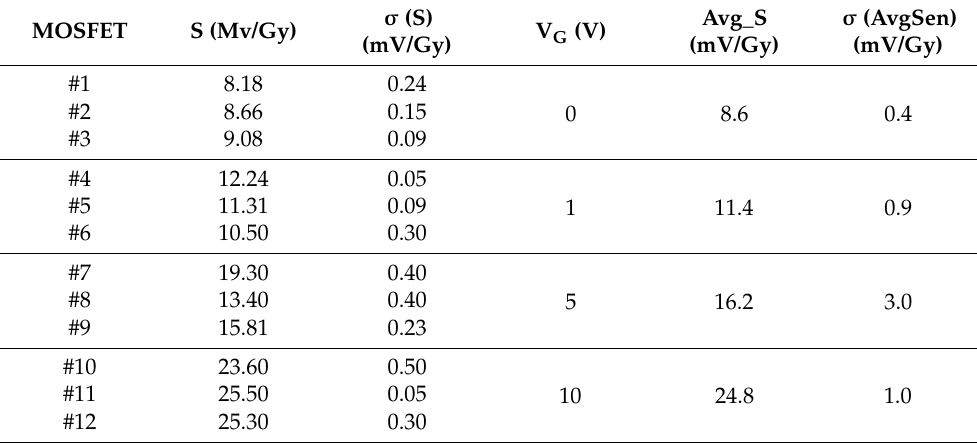
Table 1. Sensitivity per sample and average sensitivity at different bias